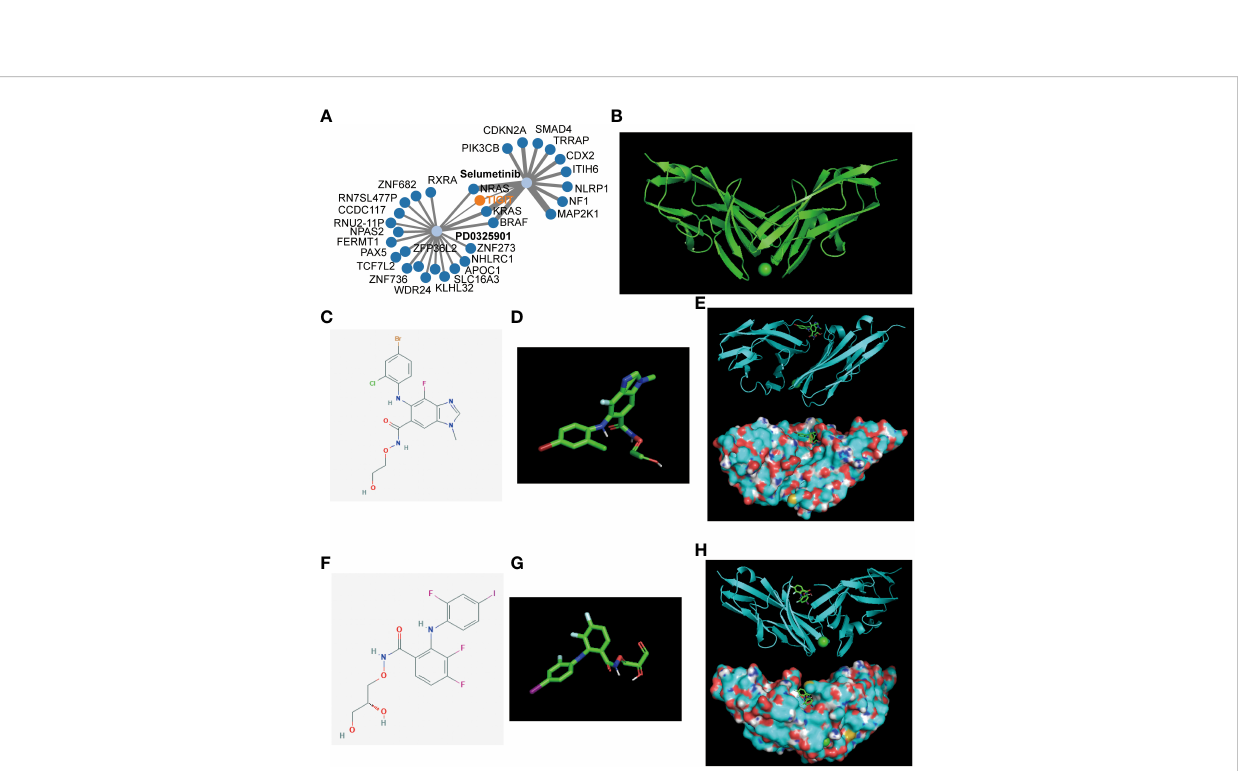
FIGURE 10 Gene-drug network and molecular docking. (A) The potential gene-drug networks target TIGIT. (B) The 3D structure of the TIGIT protein. (C) The 2D structure of Selumetinib. (D) The 3D structure of Selumetinib. (E) The molecular docking between Selumetinib and TIGIT showed Selumetinib could enter into the active pocket of TIGIT protein. (F) The 2D structure of PD0325901. (G) The 3D structure of PD0325901. (H) The molecular docking between PD0325901and TIGIT showed PD0325901could enter into the active pocket of TIGIT